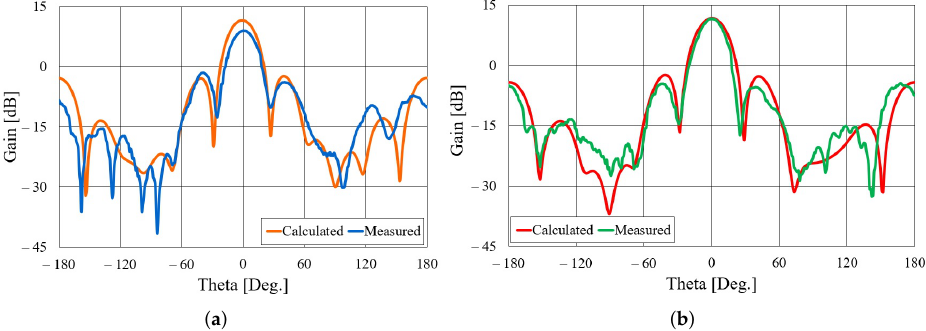
Figure 6. Radiation pattern in the H-plane of the realized slotted waveguide antennas: ( a ) Textile antenna, ( b ) aluminum